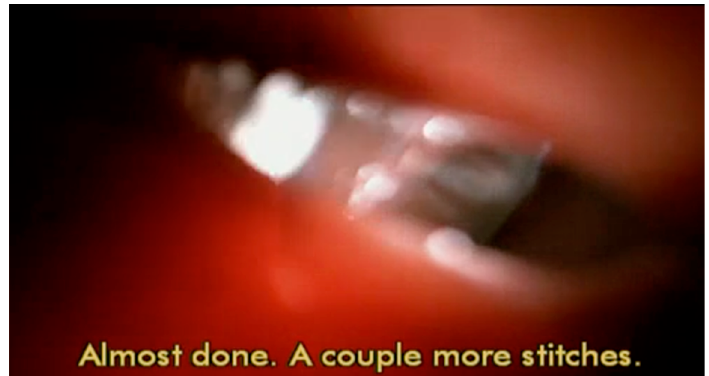
Figure 24. Image from The Diving Bell and Butterfly (2007) [34].